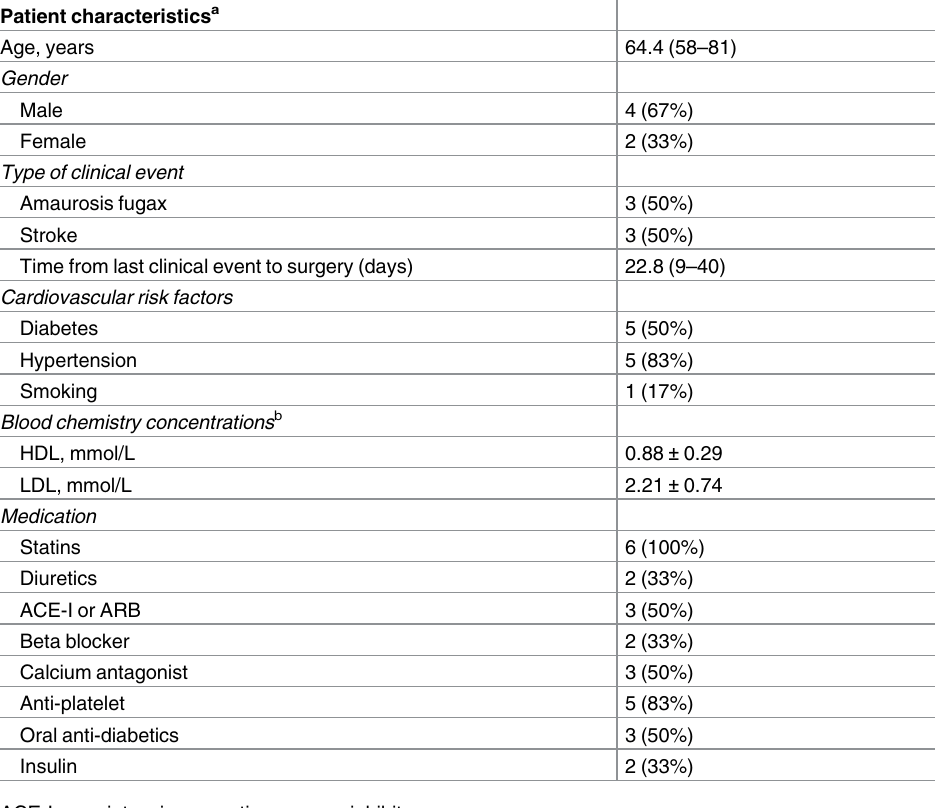
Table 1. Patient characteristics (n =